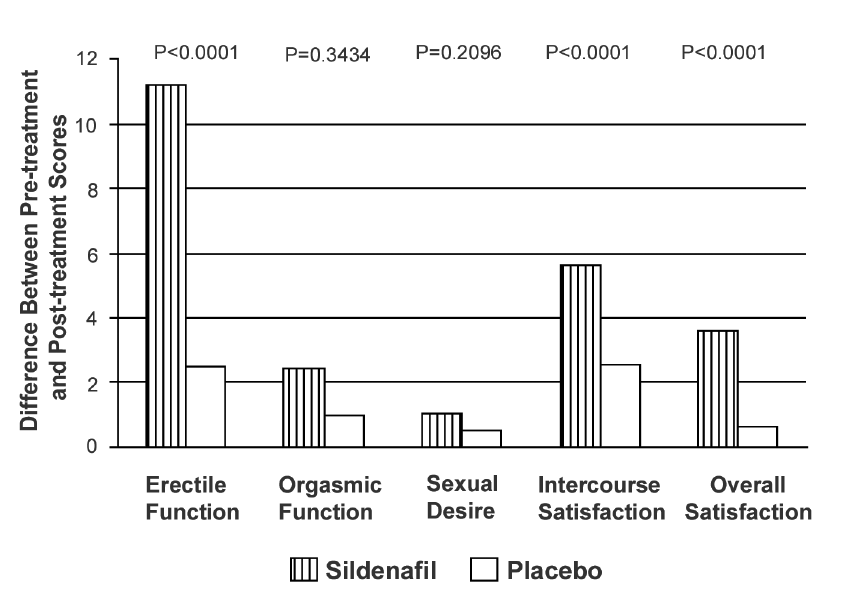
Figure 2 – Comparison between the efficacy of sildenafil and placebo, assessed by domains of the International Index of Erectile Function (evaluable sample, N=87). P values refer to the difference between sildenafil and placebo in pretreatment and post-treatment scores for each domain.